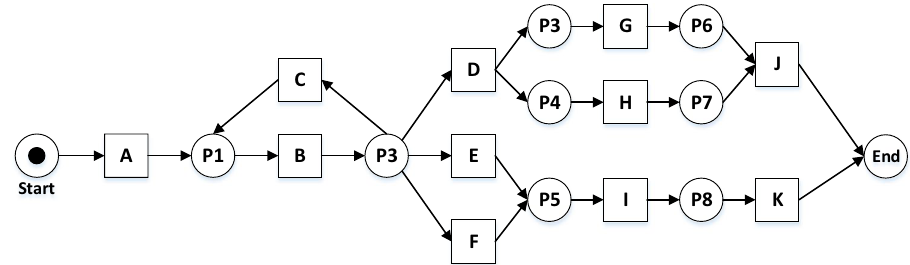
Fig. 1 An illustrating example of process